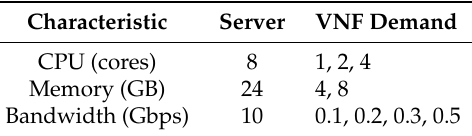
Figure 4. Infrastructure topology. Table 1. Resource